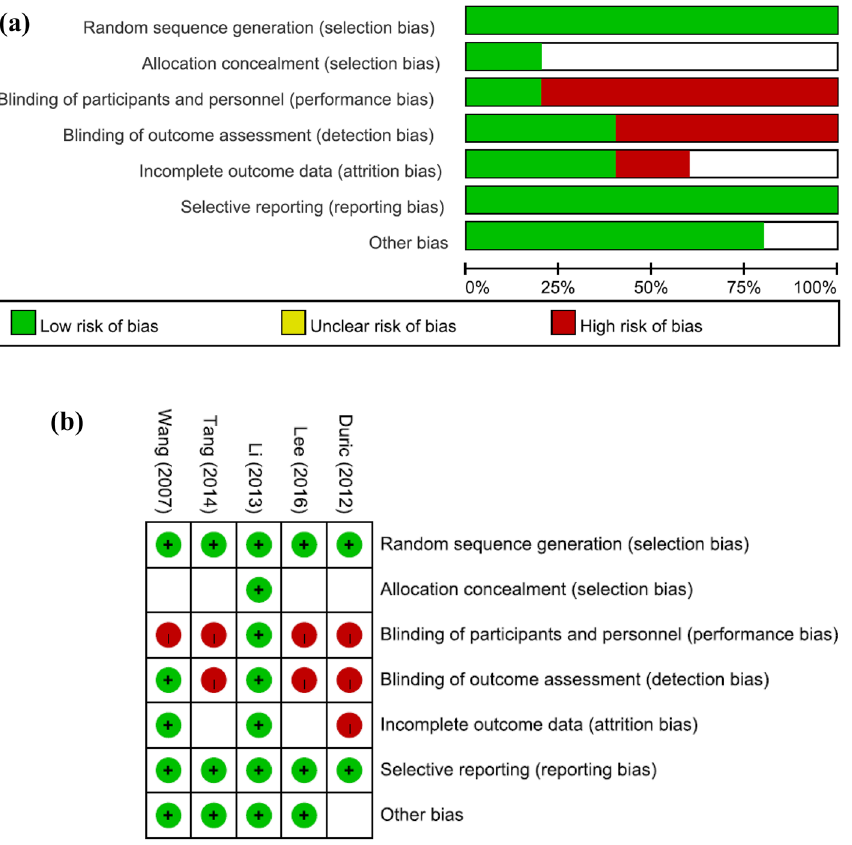
Figure 2. ( a ) Risk of bias summary ( b ) Risks of bias of the included studies.